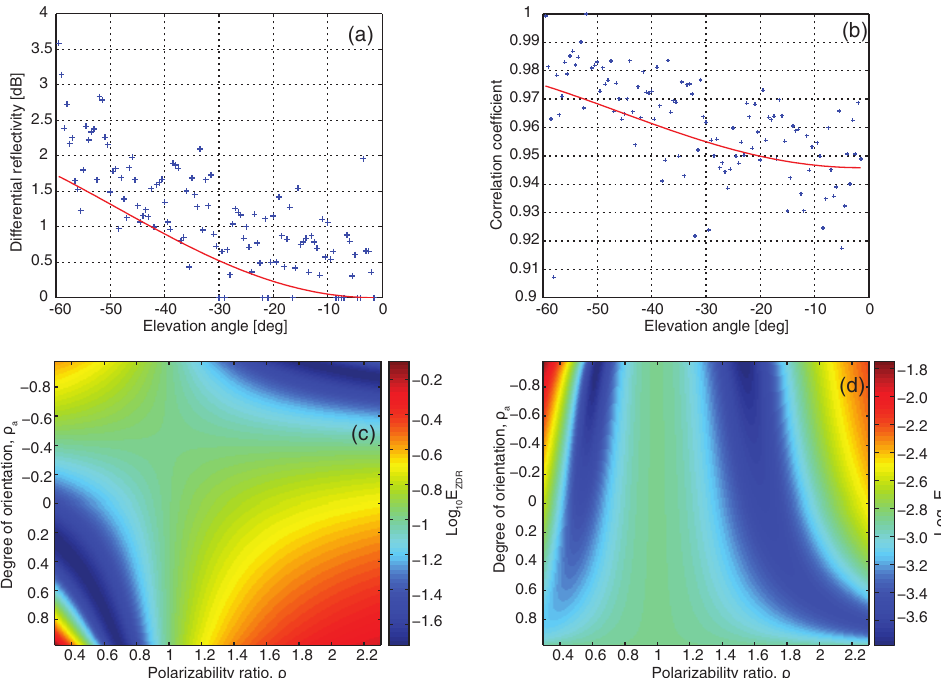
Figure 15. Measured (blue crosses) and approximated (red solid curve) elevation dependencies of differential reflectivity (a) and correlation coefficient (b) , and logarithms of E ZDR (c) and E RHV (d) . Measured data correspond to 3km height of the left half-scan of Fig. 14. According to the classification scheme described in the text, this case corresponds to a polarizability ratio of 1.6 (prolate spheroids).